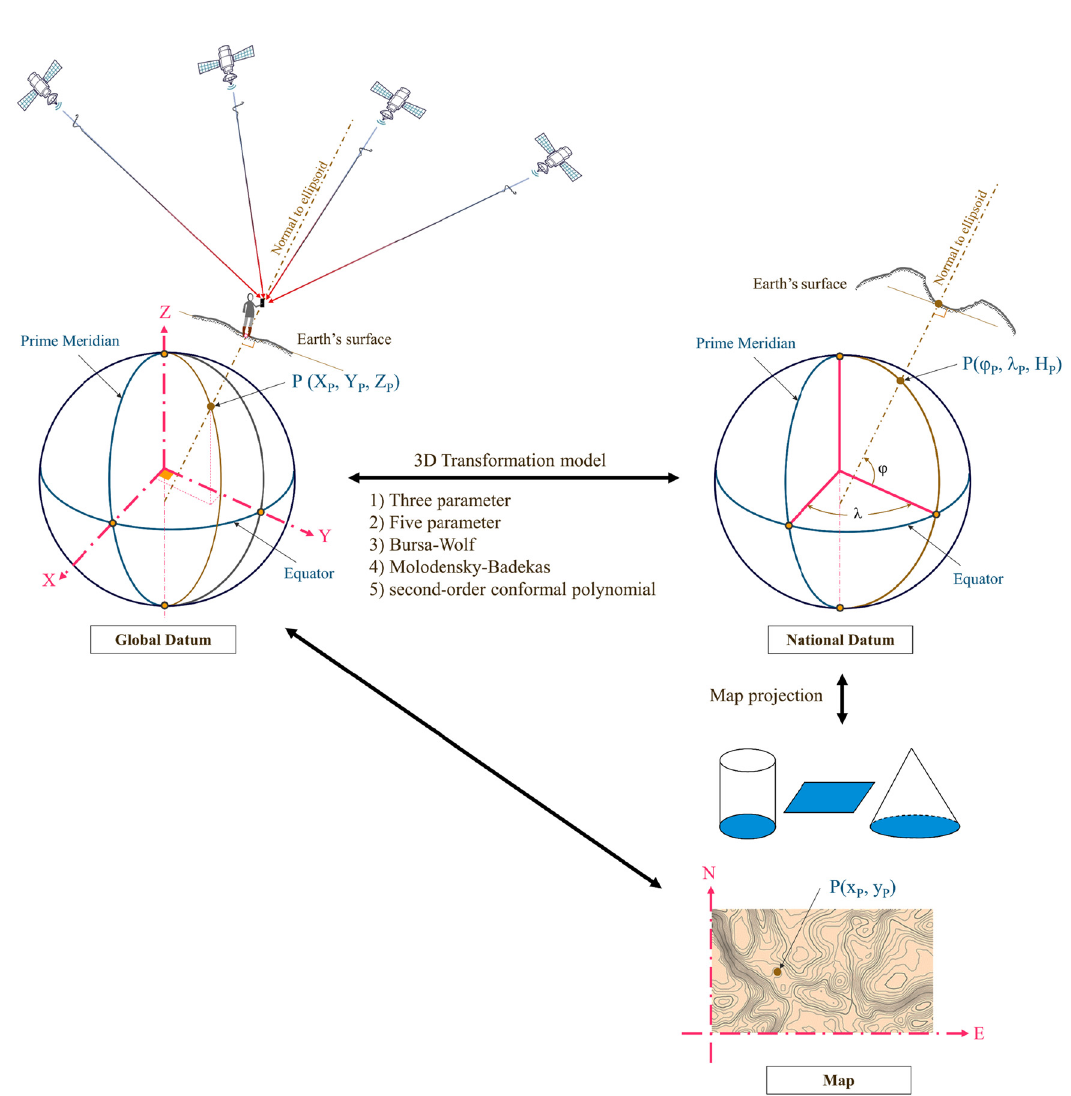
Figure 6: Data transformation and mapping process in the developed